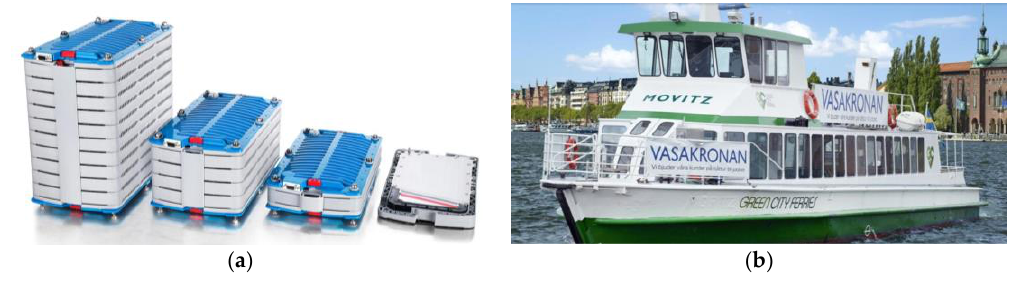
Figure 8. ( a ) Nilar’s bipolar prismatic Ni/MH batteries and ( b ) A ferry powered by them [94].